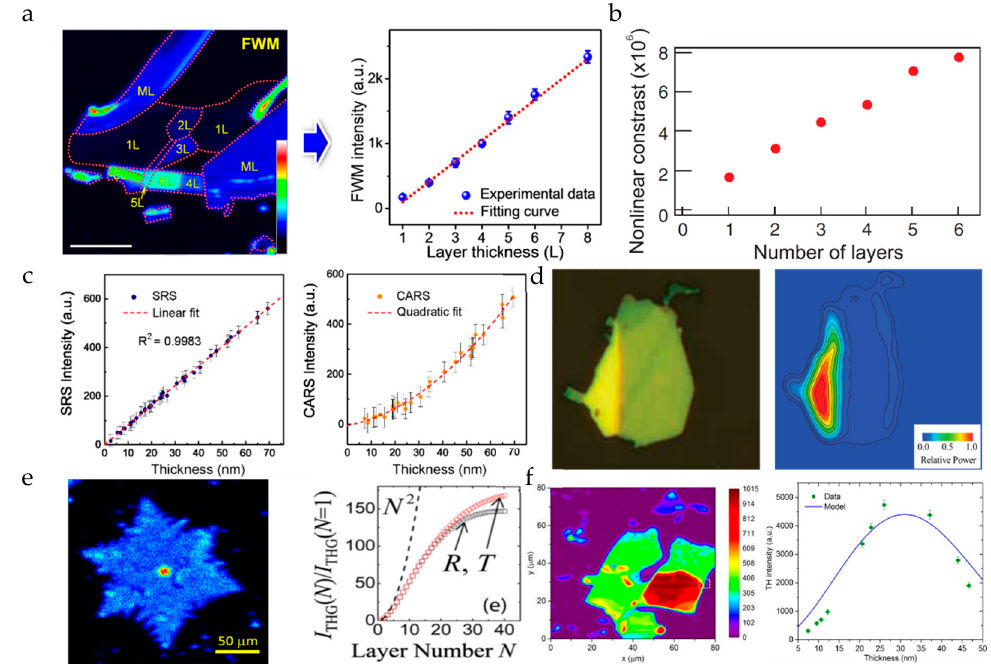
Figure 5. FWM scanning image of 2D materials and the relationship between the FWM signal strength and the number of material layers: ( a ) MoS 2 . Reproduced from [17], with permission from American Chemical Society, 2016. ( b ) Graphene. Reproduced from [46], with permission from American Physical Society, 2010. ( c ) The relationship between h-BN’s CRS (including SRS and CARS) and its layers. Reproduced from [48], with permission from American Chemical Society, 2019. THG scanning image of 2D materials and the relationship between its intensity and the number of layers: ( d ) MoS 2 . Reproduced from [49], with permission from American Chemical Society, 2014. ( e ) Graphene. Reproduced from [50]. ( f ) Black phosphorus. Reproduced from [51], with permission from AIP Publishing, 2016.